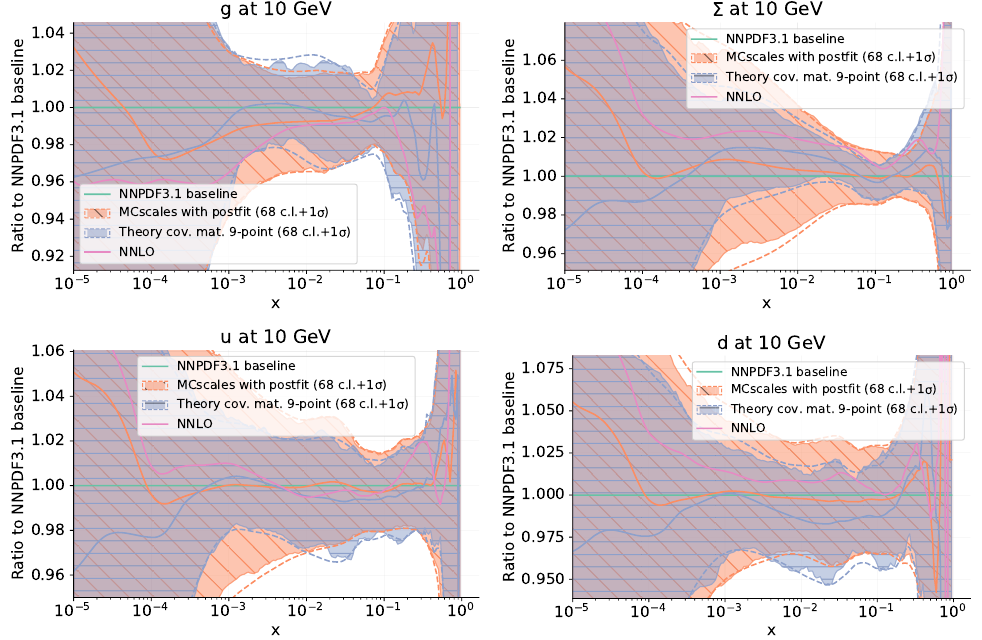
Figure 7 . Plots of the gluon (top left), singlet Σ (top right), up (bottom left) and down (bottom right) PDFs at Q = 10 GeV, where the PDF set obtained in ref. [22] by using the theory covariance matrix built with a 9-point prescription ( NNPDF31_nlo_as_0118_scalecov_9pt ) (blue) is compared to the PDF set obtained with the MCscales approach starting from a uniform prior and after postfit ( MCscales with postfit ) (orange). The central NNLO baseline set ( NNPDF31_nlo_as_0118 ) is also displayed, in pink. The PDFs are normalised to the central value of the NLO baseline set ( NNPDF31_nlo_as_0118 , green). We note that cross section computations using the MCscales sets should use matched scale variations in the partonic cross section (see section 4), which heavily limits the interpretability of this